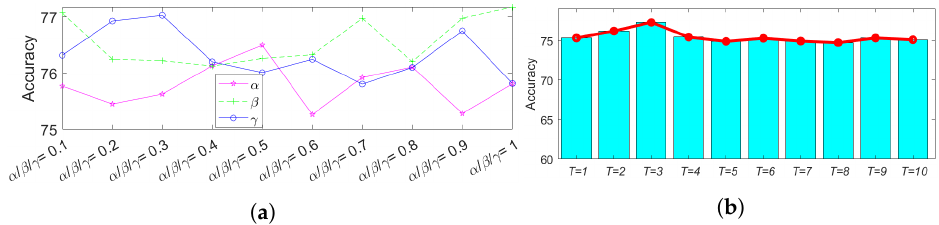
Figure 5. Parameter analysis for α , β , γ , and T . The effect of different α , β , and γ on test accuracy is shown in ( a ), and effect of different T on test accuracy is shown in ( b ). When α = 0.5, β = 1, and γ = 0.3, and T = 3, accuracy is highest.